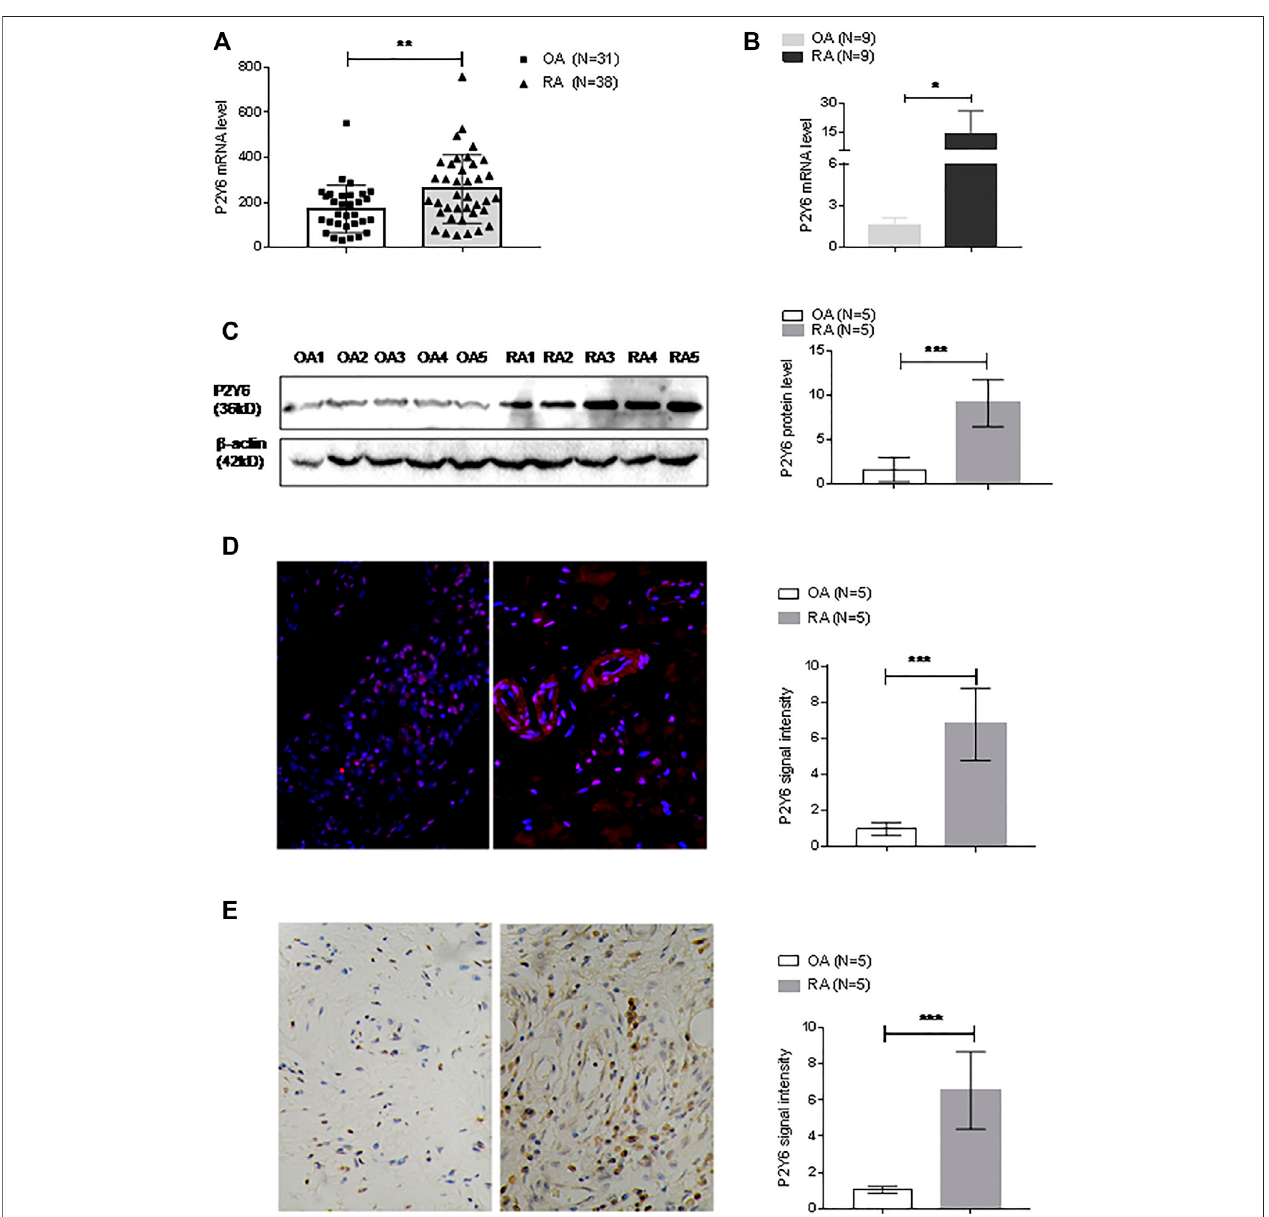
FIGURE5| P2Y6expressioninsynovialtissuesandculturedsynovial fi broblastcells. (A) P2Y6expressionlevelswereanalyzedbasedontheGEOdatabasebased on synovial tissue microarray data of RA synovial tissue ( n (cid:1) 38) and OA ( n (cid:1) 31). (B) P2Y6 mRNA expression in synovial tissues from RA or OA patients ( n (cid:1) 9 for each disease)wasassessedusingreal-timePCR. (C) P2Y6proteinexpressioninsynovialtissuesfromRAorOApatients( n (cid:1) 5foreachdisease)wasassessedusingWestern blotting and statistical analysis. (D) P2Y6 protein expression in RA or OA synovial tissues ( n (cid:1) 5 for each disease) was assessed using immuno fl uorescence